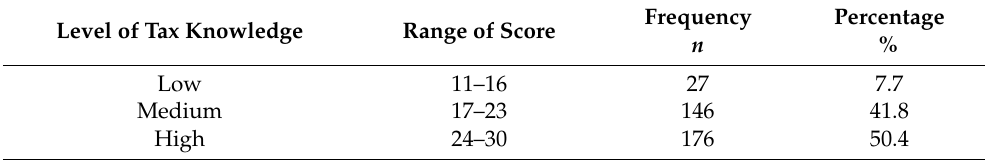
Table 6. Level of tax